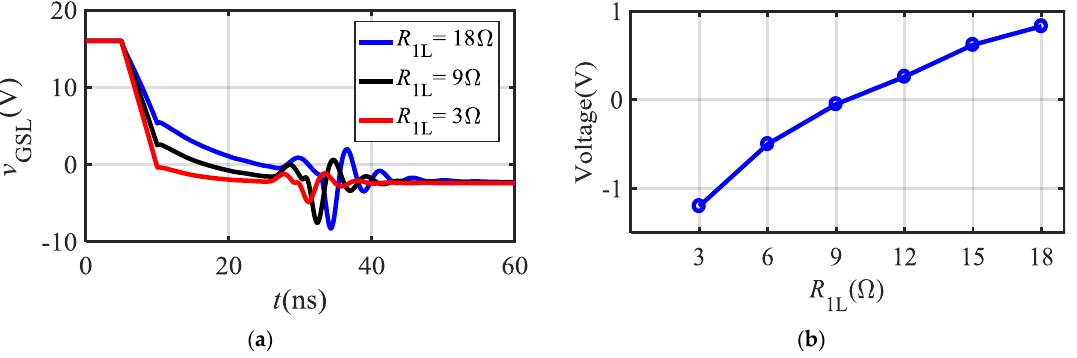
Figure 10. ( a ) Gate-source voltage of low-side MOSFET under different R 1L values ( b ) relationship between R 1L and spurious peak voltage.